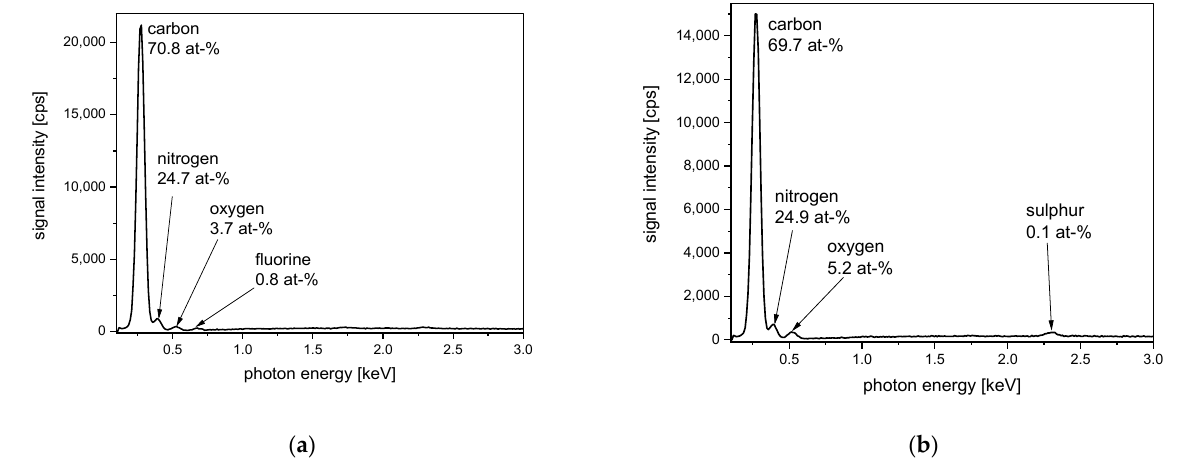
Figure 11. EDS spectra of PAN samples taken from a non-woven filter material—( a ) PAN homopolymer; ( b ) PAN copolymer.